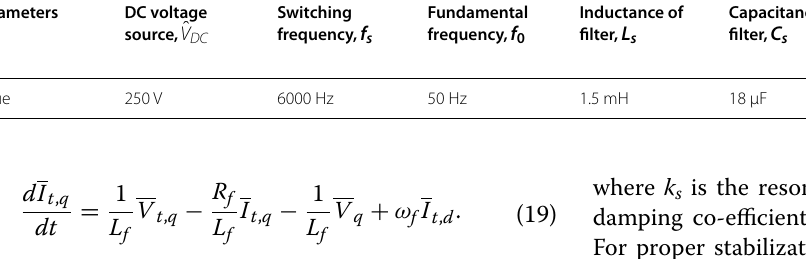
Table 1 Parameters of single‑phase MG